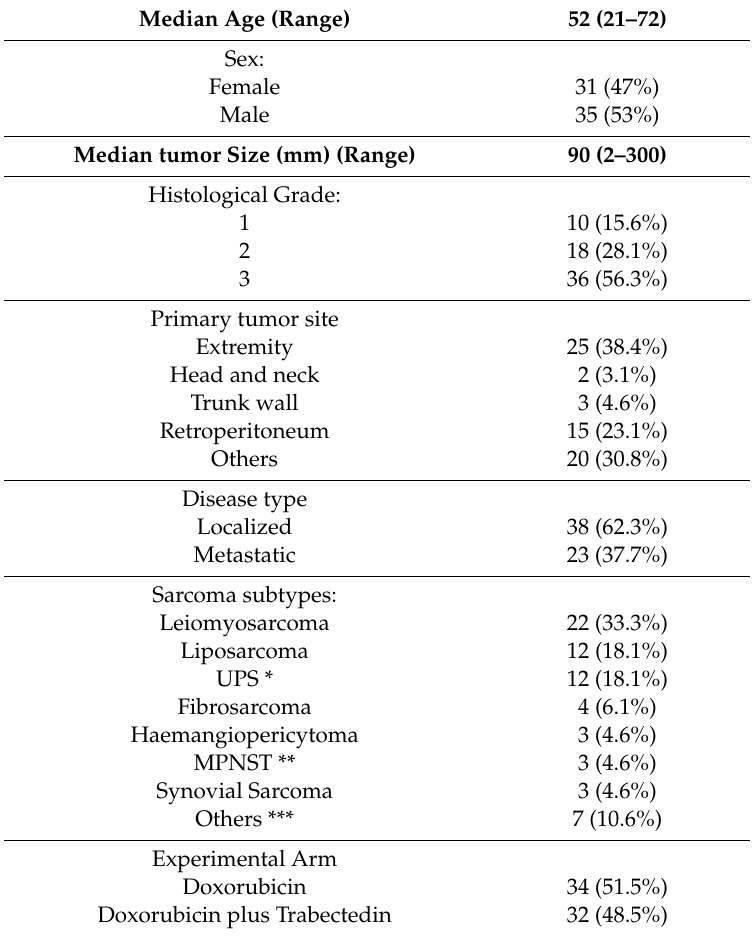
Table 1. Demographics and clinical-pathologic information ( n =